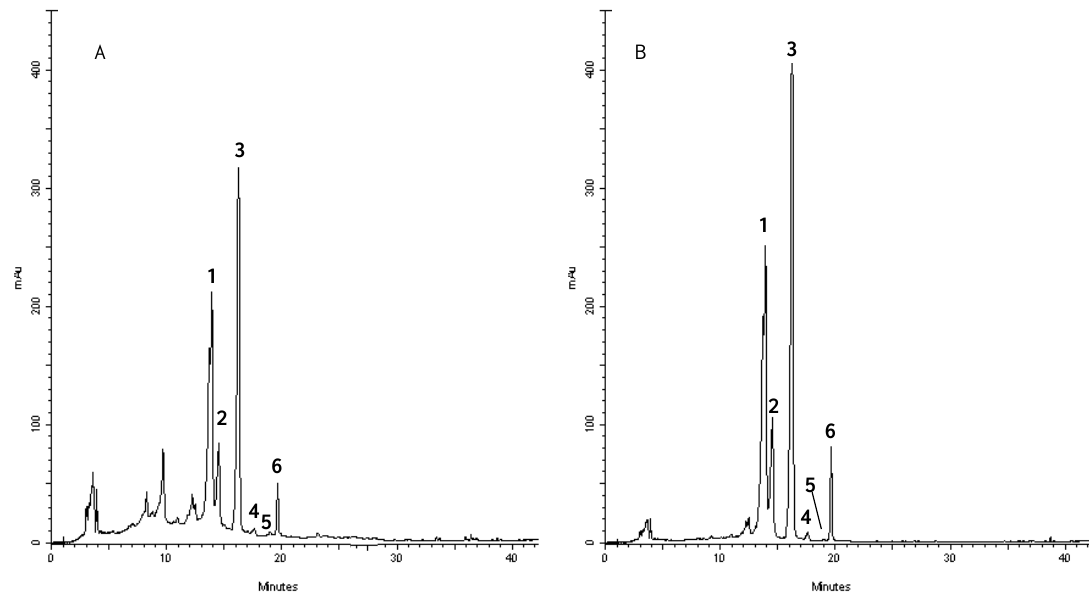
Figure 3. Representative HPLC chromatograms of flavonoids derivatives of Jatropha curcas L. methanol extract: absorbance at 278 nm ( A ) and 325 nm ( B ). Peak identification was performed by matching retention time and UV spectra against commercially available reference compounds. Peaks: vicenin-2 ( 1 ); stellarin-2 ( 2 ); vitexin ( 3 ); isovitexin ( 4 ); isorhoifolin ( 5 ); and rhoifolin ( 6 ). The quantifications of the identified flavonoids are depicted in Table 3. Flavonoids content in methanol extract of Jatropha curcas L. leaves.